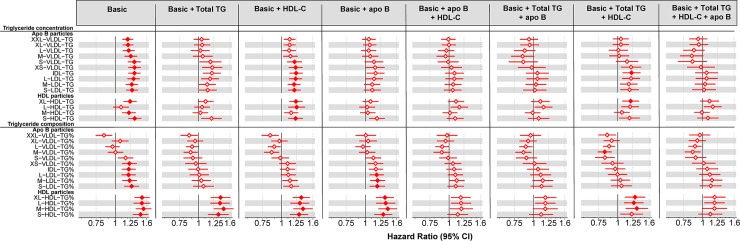
Observational associations of circulating triglyceride concentrations and triglyceride composition in lipoprotein subclass particles and risk of incident CHD with multiple adjustments.Hazard ratios for incident CHD per SD higher circulating triglyceride concentrations (upper part) and triglyceride composition (lower part) in lipoprotein subclass particles within each size-specific lipoprotein subclass adjusted for traditional risk factors and gradually for 3 fundamental measures that characterize the overall lipoprotein profile pretty well, namely, total serum triglyceride (total TG), HDL cholesterol (HDL-C), and apolipoprotein B (apoB) concentration. Closed circles represent statistical significance of associations at P < 0.002 and open circles associations that are nonsignificant at this threshold. The horizontal bars refer to the 95% CIs. Underlying data can be found in S1 Data. Apo B, apolipoprotein B; C, cholesterol; CHD, coronary heart disease; HDL, high-density lipoprotein; IDL, intermediate-density lipoprotein; LDL, low-density lipoprotein; TG, triglycerides; VLDL, very-low-density lipoprotein.